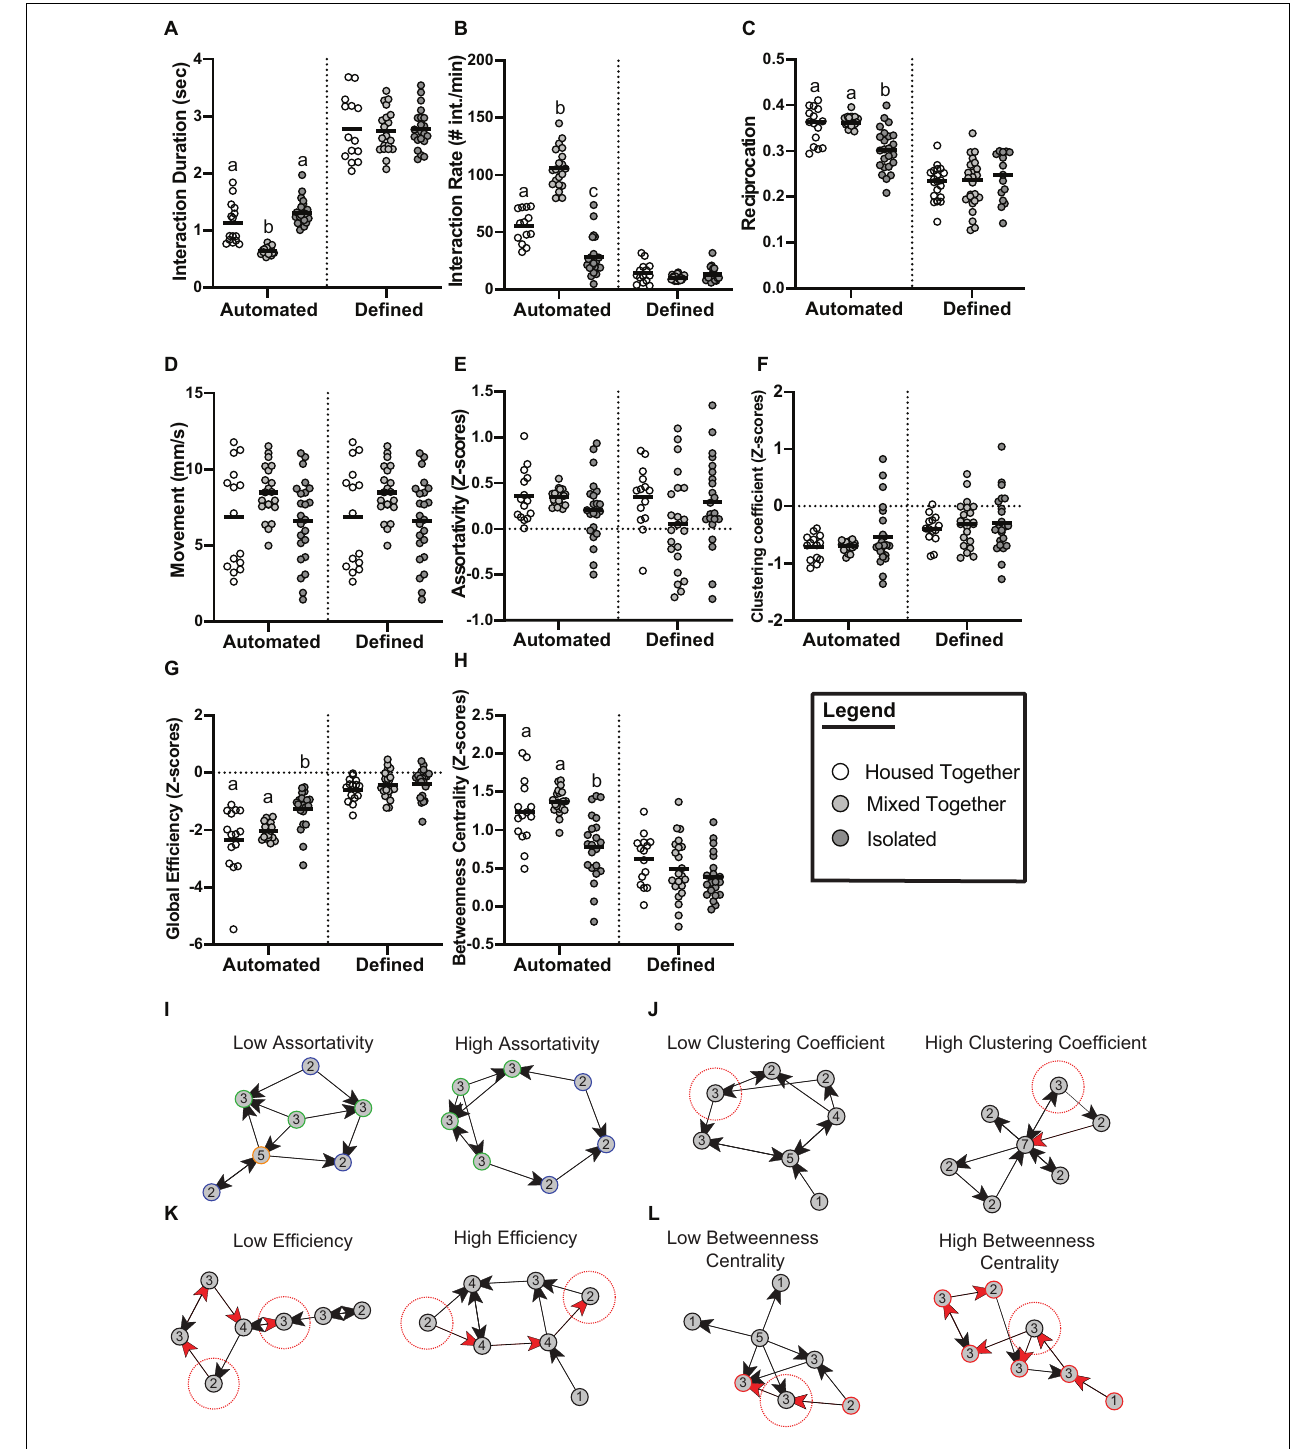
FIGURE 2 | Emerging properties of social networks after social isolation. Data from Schneider et al. (2012) re-analyzed with automated criteria compared to the original published data with fixed criteria reveals social experience significantly affects social interaction measures (A–D) and social network measures (E–H) . Flies were divided into three treatments: (i) Housed together (white) meaning all 12 flies in one video trial were raised together ( n = 15 trials); (ii) Mixed together (light gray) meaning all 12 flies in one video trial were unfamiliar with each other from being raised with other flies ( n = 22 trials); (iii) Isolated (dark gray) meaning all 12 flies in one video trial were completely socially isolated since eclosion ( n = 24 trials). (A) Flies of the mixed group have significantly lower average interaction duration when analyzed using the automated criteria ( p ≤ 0.0001). (B) Flies of the isolated treatment have significantly lower rates of interaction when analyzed using the